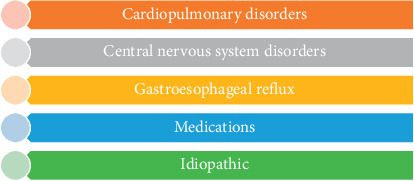
Etiology of hiccups.